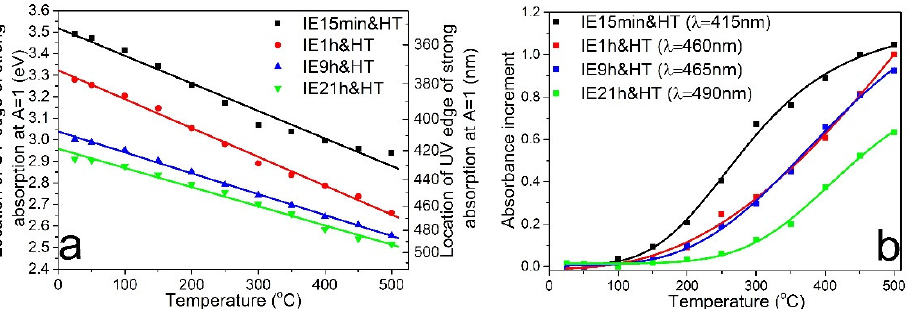
Figure 13. ( a ) Location of UV absorption edge and ( b ) absorbance increment at a fixed wavelength vs. temperature for PTR-Br glass samples ion-exchanged for different time and heat-treated at 500 °C for 9 h.